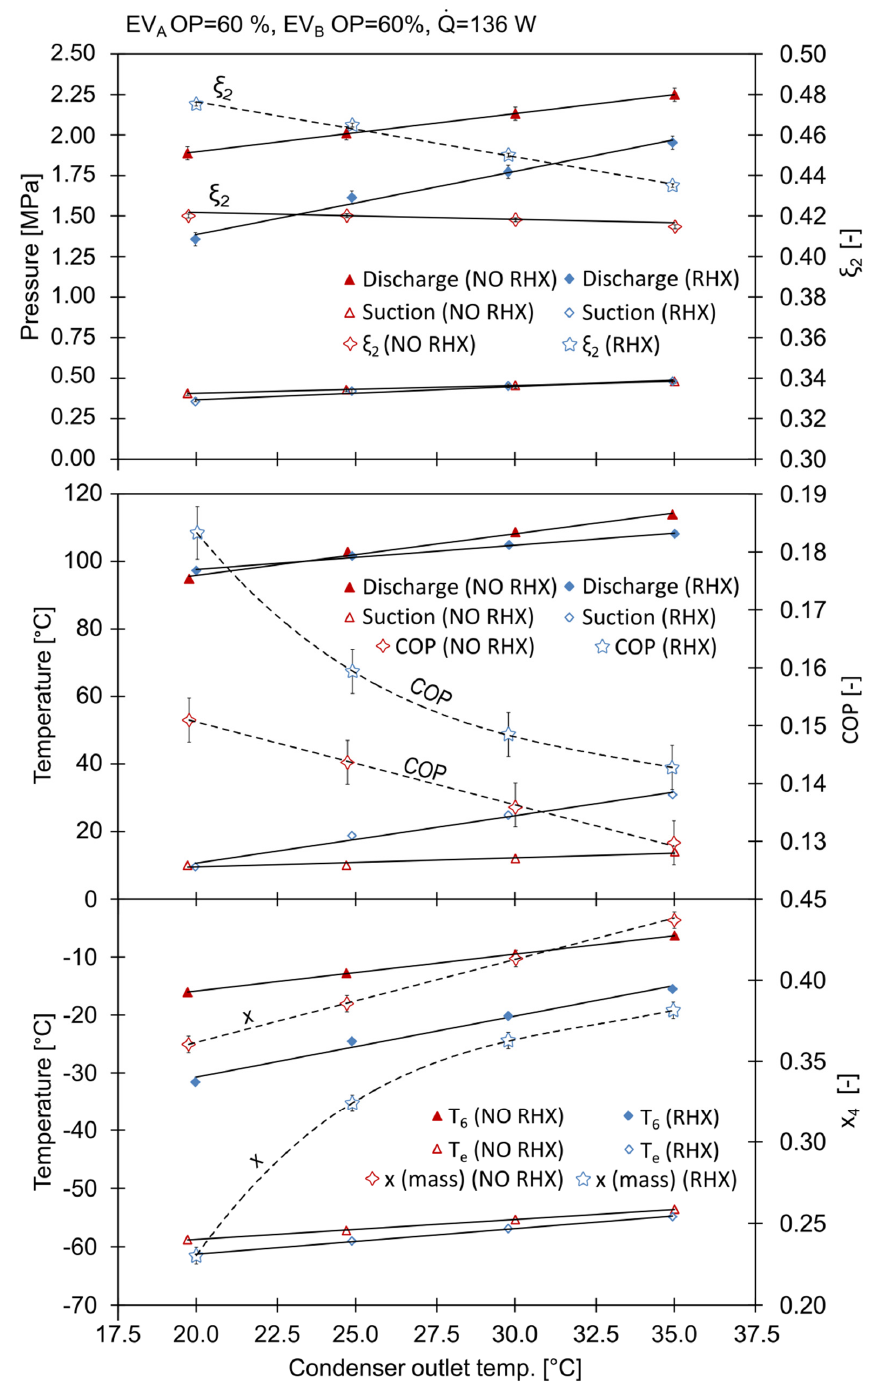
Figure 5. The influence of condensing temperature and RHX on system parameters.